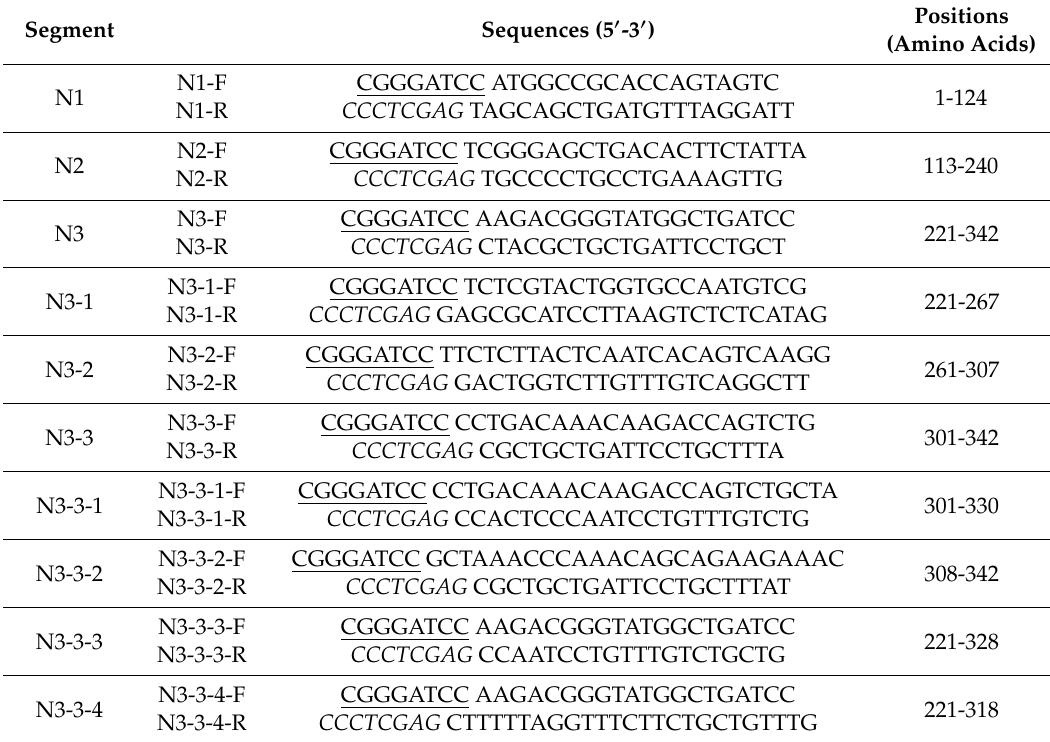
Table 1. Sequence of the oligonucleotides used for